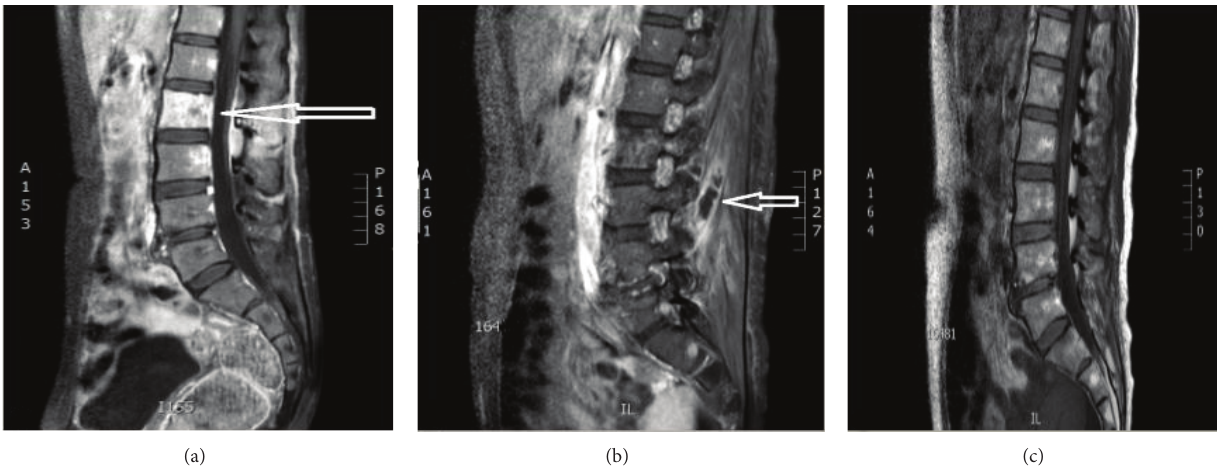
Figure 1: MRI lumbar spine. (a) MRI of the lumbar spine with contrast showing L2 vertebral osteomyelitis. (b) MRI of the lumbar spine showing paraspinal abscess. (c) Follow-up MRI of the lumbar spine showing resolution of the osteomyelitis and the paraspinal abscesses.